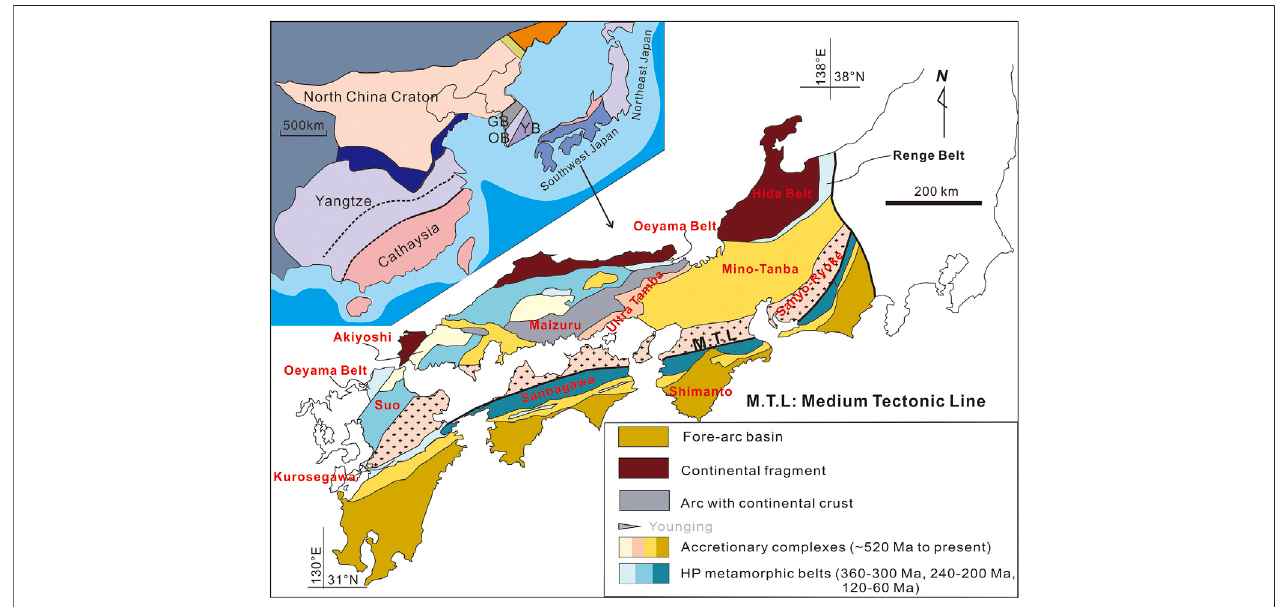
FIGURE8| Simpli fi edgeologicalmapofmajorpartsofEastAsiaandSouthwestJapan.Modi fi edafterOhandKim(2021),Tsujimori(2002)andPastor-Galánetal. (2021).